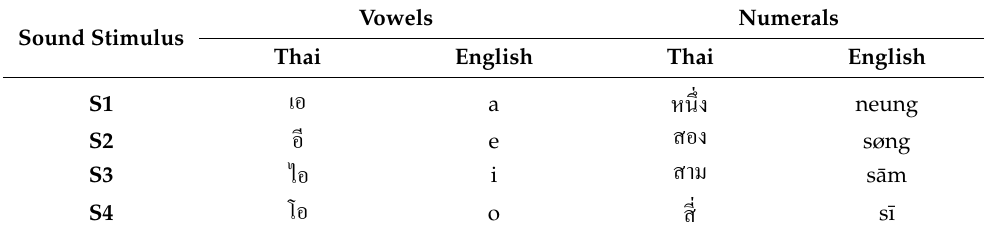
Table 2. Vowel and numeral sounds for auditory-evoked potential stimulation.